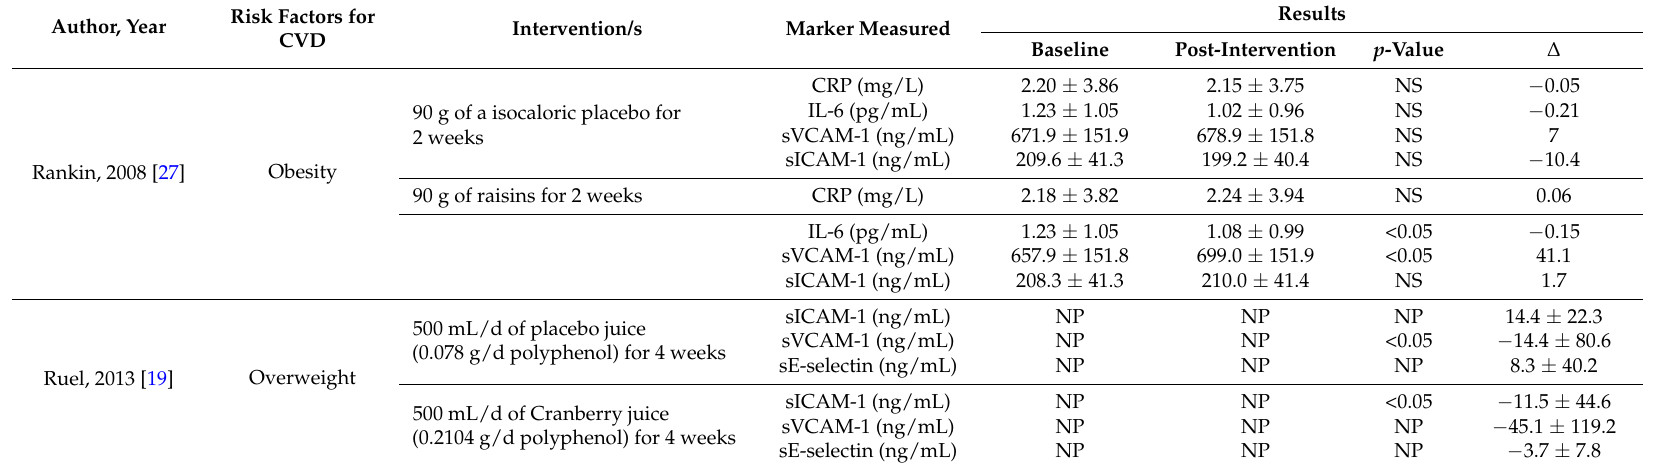
Table 7. Effect of other fruit polyphenols on inflammatory markers at baseline and post-intervention.